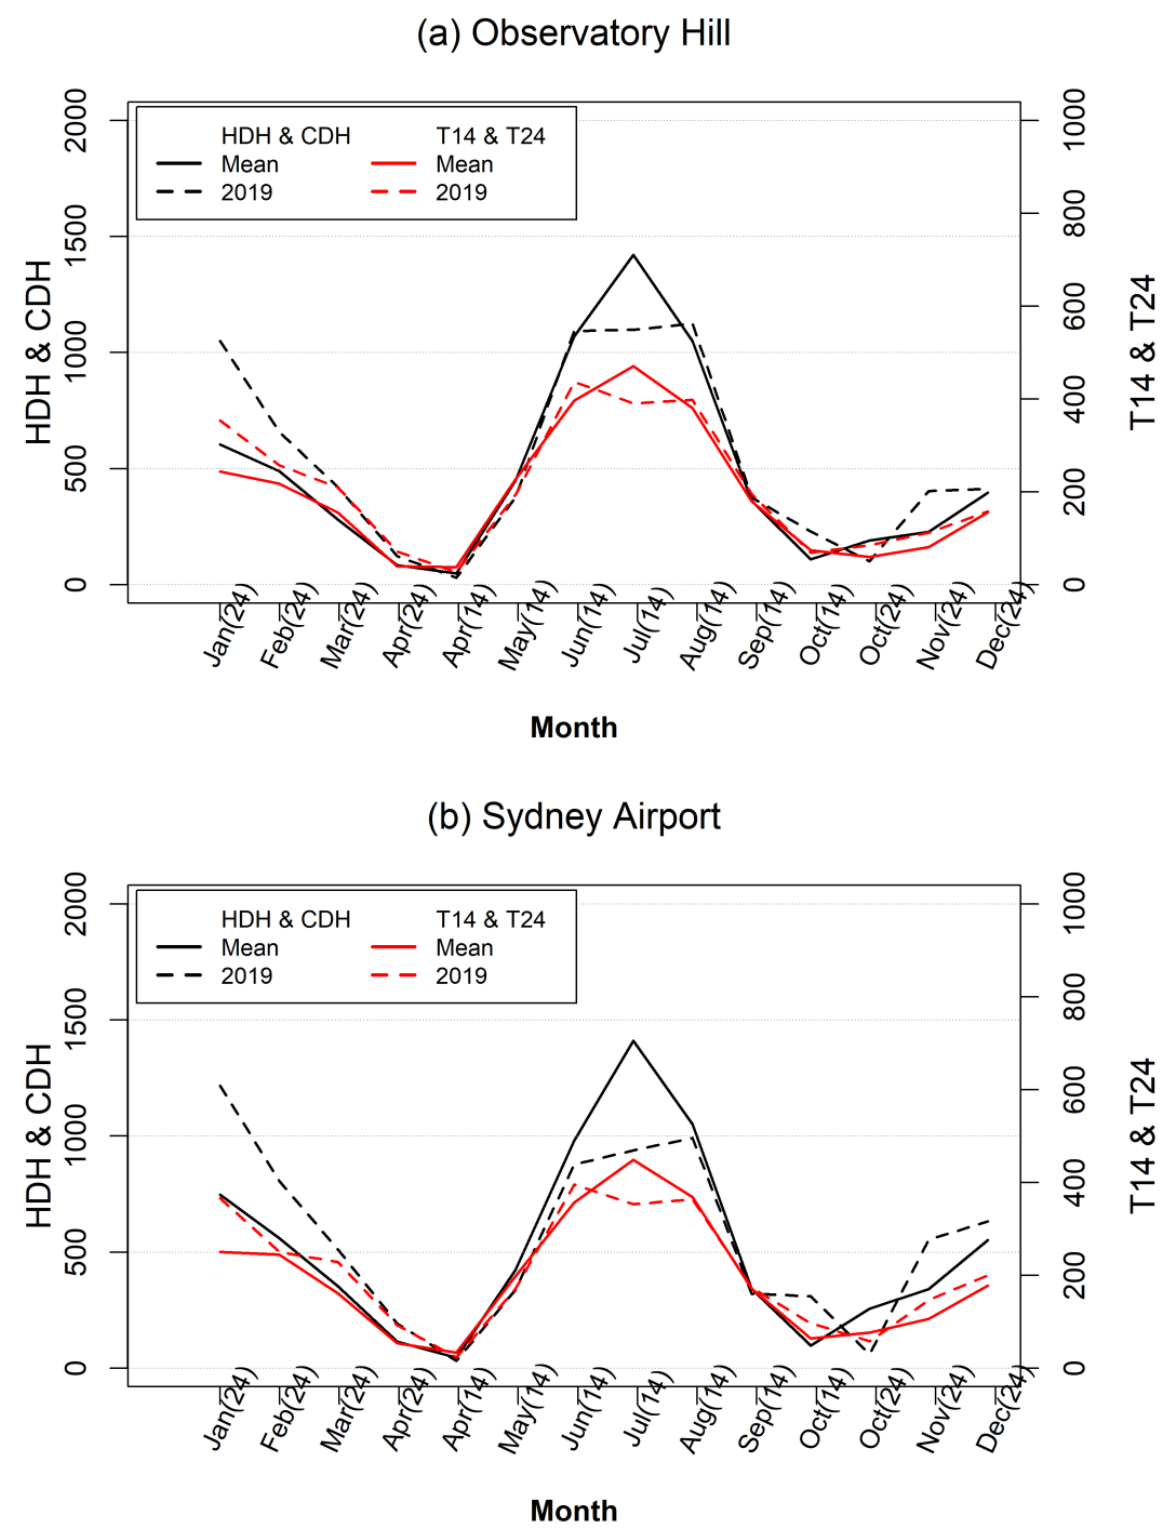
Figure 7. Mean monthly values of CDH, HDH, T24 and T14 for period 1999 – 2018 and 2019 at ( a ) Observatory Hill and ( b ) Sydney airport stations.